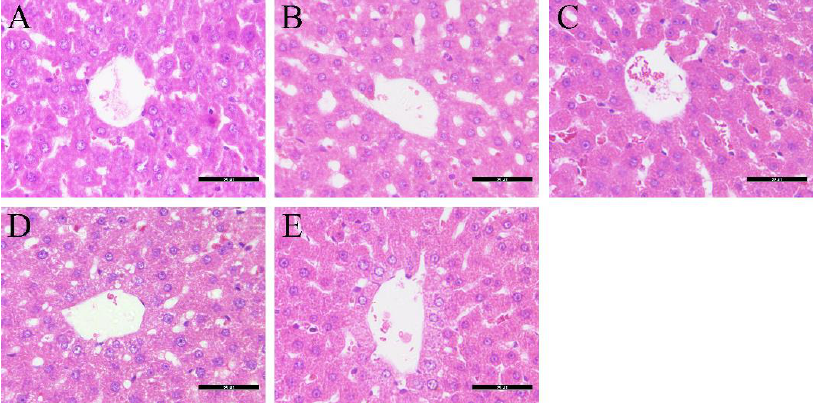
Figure 2. Histopathological observation of liver tissue in each group. Samples were stained with H&E and photographed at 200× magnification. ( A ) Liver of ZDF rats (fa/+); ( B ) liver of ZDF rats (fa/fa); ( C ) liver of ZDF rats (fa/fa) treatment with glimepiride; ( D ) liver of ZDF rats (fa/fa) treatment with metformin; ( E ) liver of ZDF rats (fa/fa) treatment with their combination.